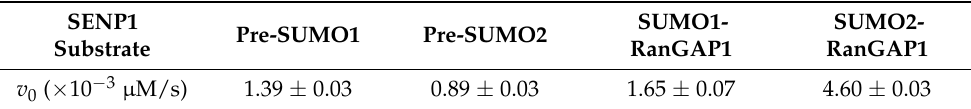
Table 2. The initial velocity ( v 0 ) of SUMO1-RanGAP1C deconjugation by SENP1C derived by qFRET analysis.